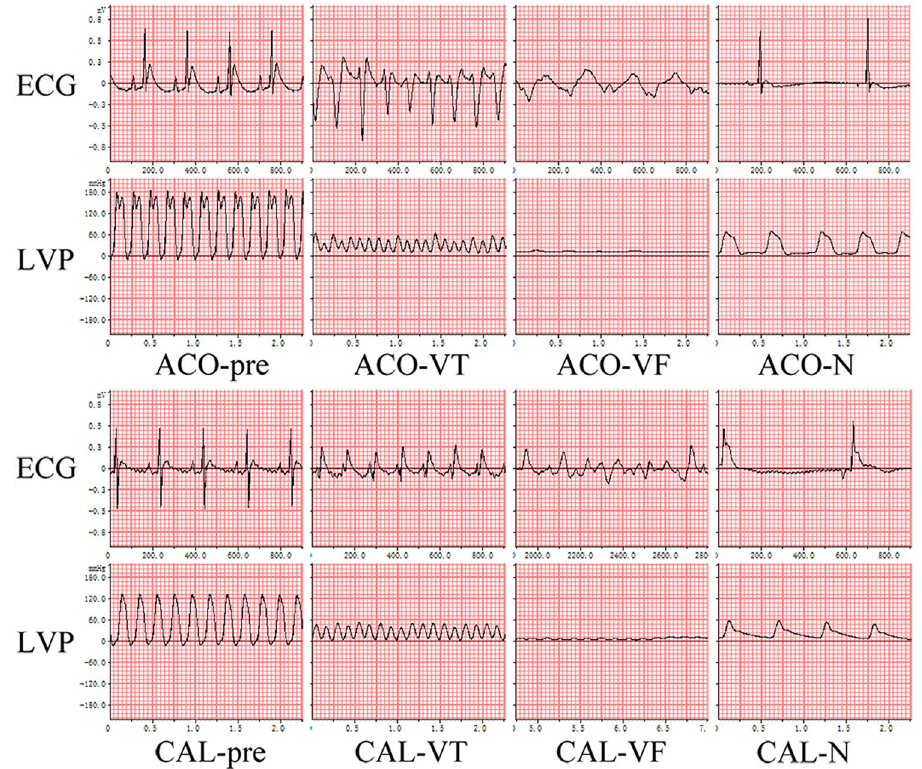
Figure 1. ECG and hemodynamic features of two LVTA models and controls. Both LVTA models (ACO-VT, ACO-VF, CAL-VT, CAL-VF) experienced VT, VF, and a dramatic decrease in LVP. Control subjects (ACO-N and CAL-N) experienced bradycardia and mildly decreased LVP when compared to controls; ACO-pre and CAL-pre: measurements taken prior to treatments; measurements during VT or VF in LVTA models; ECG: electrocardiogram; LVP: left ventricular pressure; VT: ventricular tachycardia; VF: ventricular